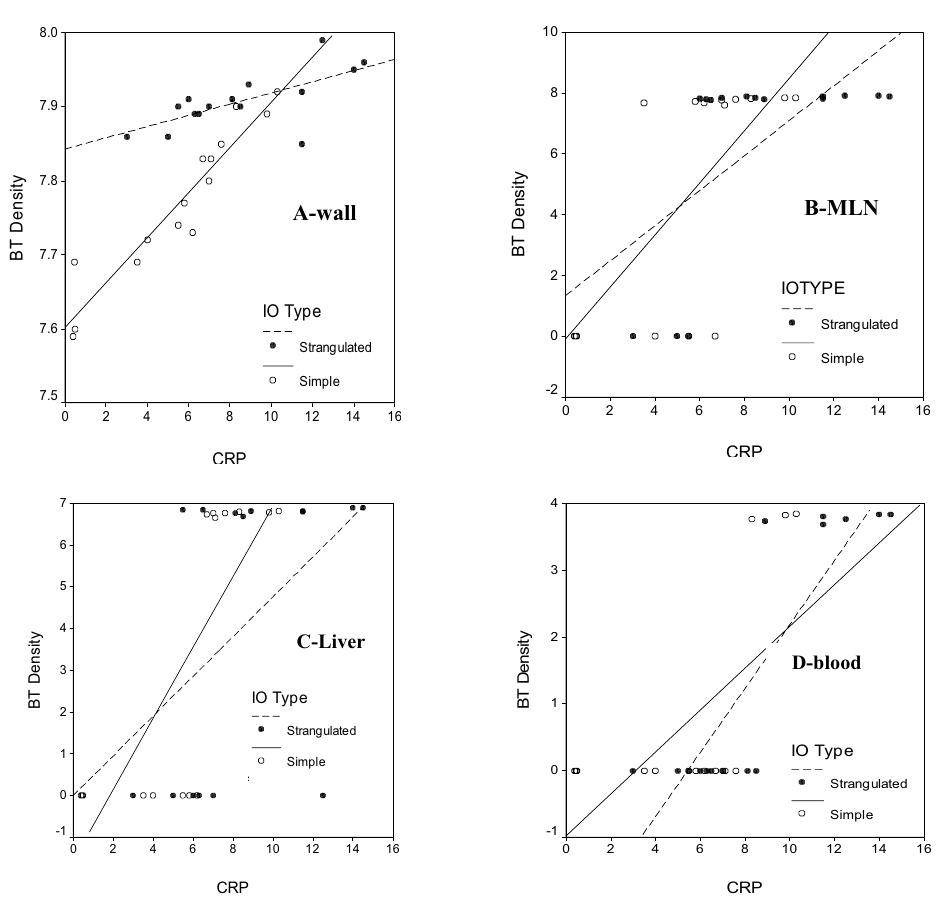
FIGURE 4 - Scatter plots showing relation between logarithmic BT density and CRP level in both simple and strangulated I.O within the wall (a), MLN (B), liver (C) and systemic blood